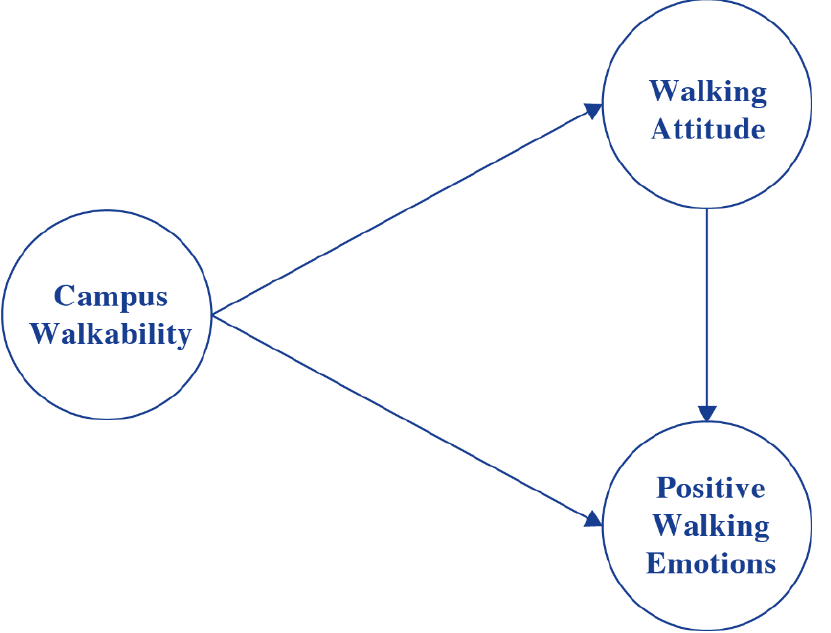
Figure 1. Conceptual model of the relationships between campus walkability, walking attitude, and affective walking experience (positive walking emotions). Hypothesis 1 (H1). Campus walkability has a direct relationship with walking attitudes, i.e.,